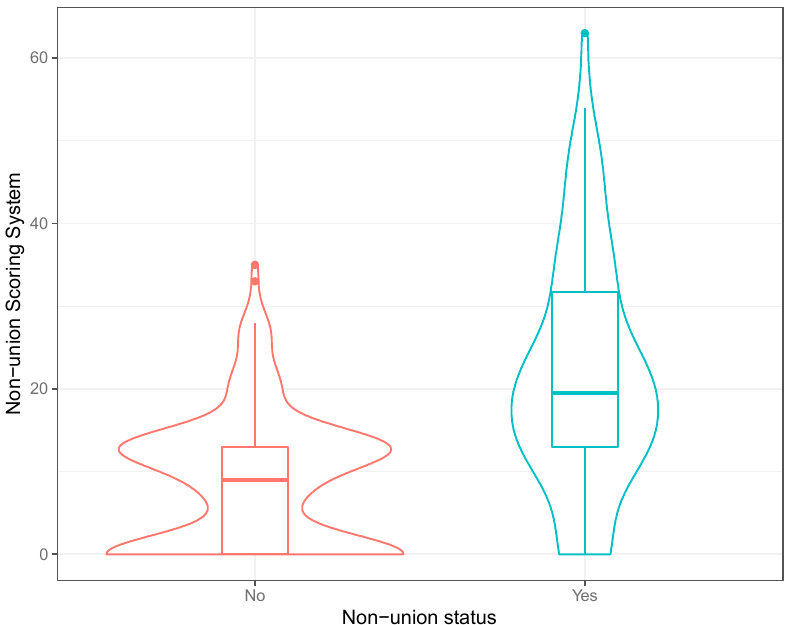
Figure 2. Violin plot of the non-union scoring system (excluding self-dynamisation). A boxplot of the distribution has been included within the violin plot.